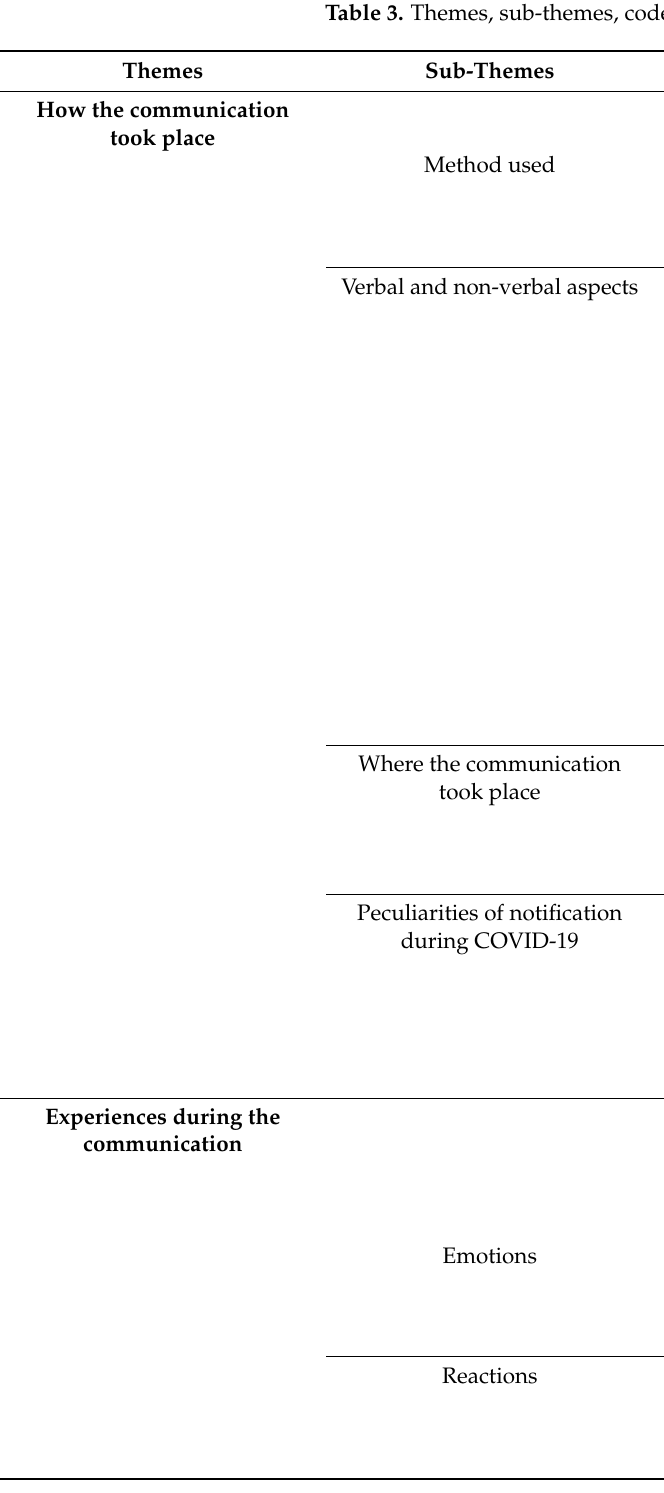
Table 3. Themes, sub-themes, codes and observed